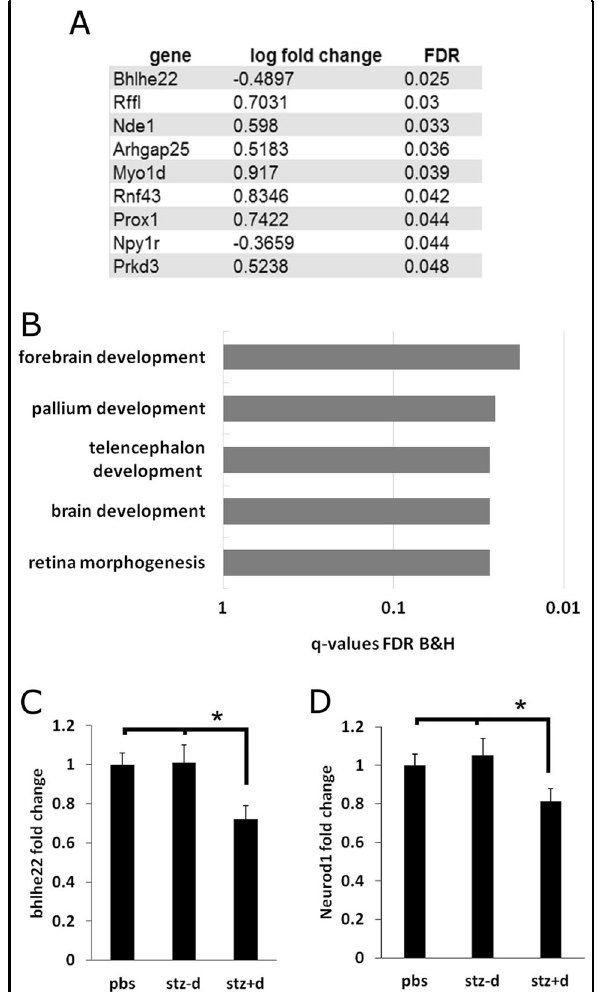
Fig. 4 Effects of gestational diabetes on cortical gene transcription. RNA-seq analysis was performed on frontal cortex and striatum samples from all experimental groups. A List of genes that were differentially expressed in the STZ + D frontal cortex. B Gene ontology analysis of the differentially expressed genes from the frontal cortex shows enrichment of genes involved in forebrain development. C , D Real-Time PCR analysis of genes bhlhe22 and Neurod1 in all three experimental groups. Data are presented as mean ± standard error of the mean. One way Anova. * p < 0.05 n = 7 per experimental